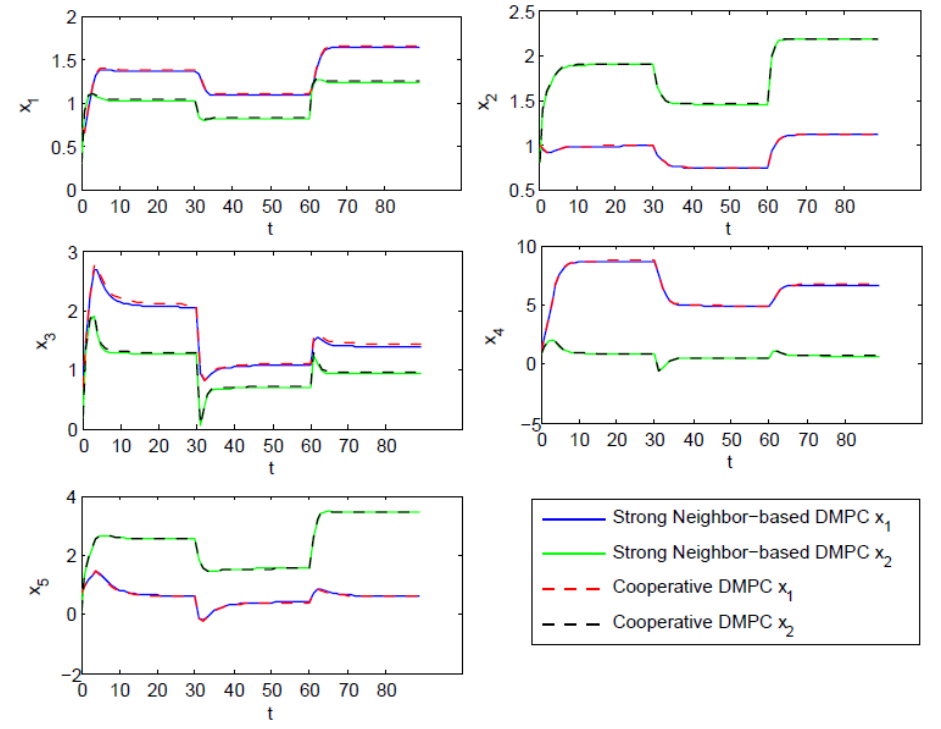
Figure 2. States of each subsystem under the control of strong-coupling neighbor-based DMPC (SCN-DMPC) and cooperative DMPC.